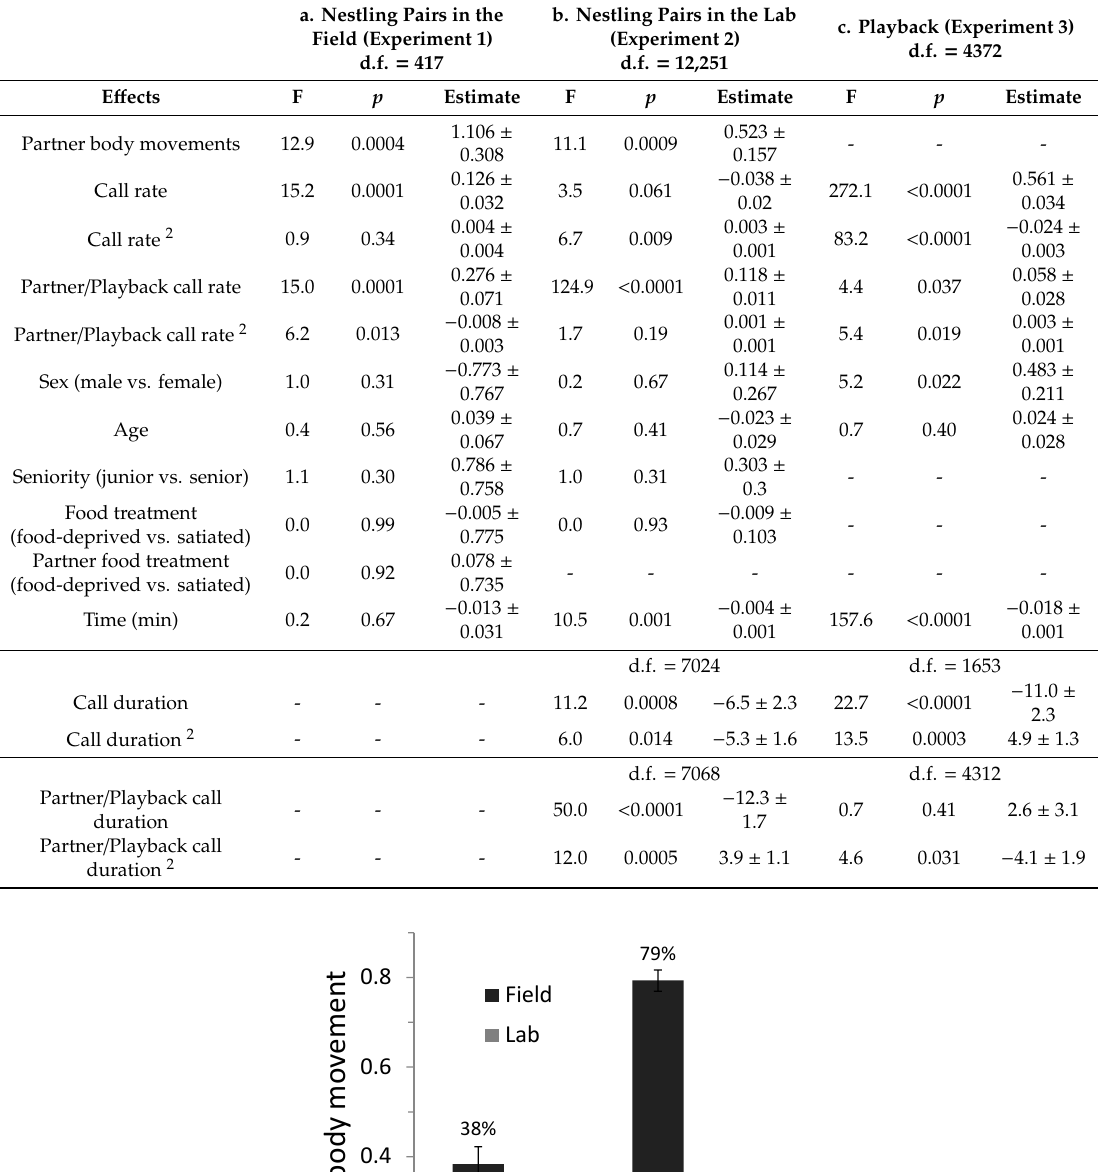
Table 1. Nestlings’ likelihood of performing body movements, according to their own vocal behavior, food treatment, and characteristics and the vocal behavior and food treatment of their nestmate (live partner or playback). Three settings are analyzed: (a) nestling pairs in their natural nest, (b) nestling pairs in the laboratory, and (c) singleton nestlings responding to a playback. Result of generalized linear models. Superscript numbers indicate quadratic terms (see main text).